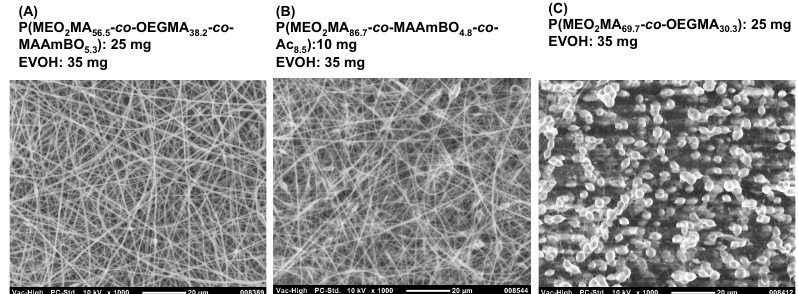
Figure 4. SEM images of electro-spinning samples: ( A ) P(MEO 2 MA 56.5 - co -OEGMA 38.2 - co -MAAmBO 5.3 ) (25 mg) and EVOH (35 mg), ( B ) P(MEO 2 MA 86.7 - co -MAAmBO 4.8 - co -Ac 8.5 ) (10 mg) and EVOH (35 mg) and ( C ) P(MEO 2 MA 69.7 - co -OEGMA 30.3 ) (25 mg) and EVOH (35 mg) in 1 mL HFIP.